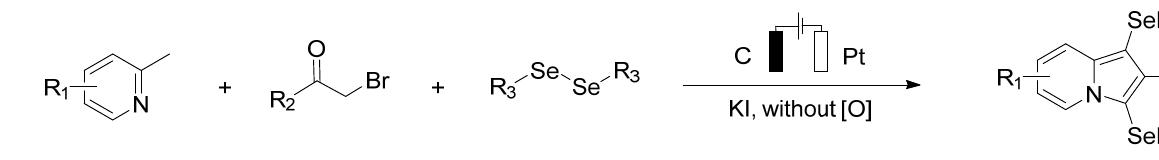
Figure 4. Reactions and selenium compound synthesized electrochemically by Li et al.